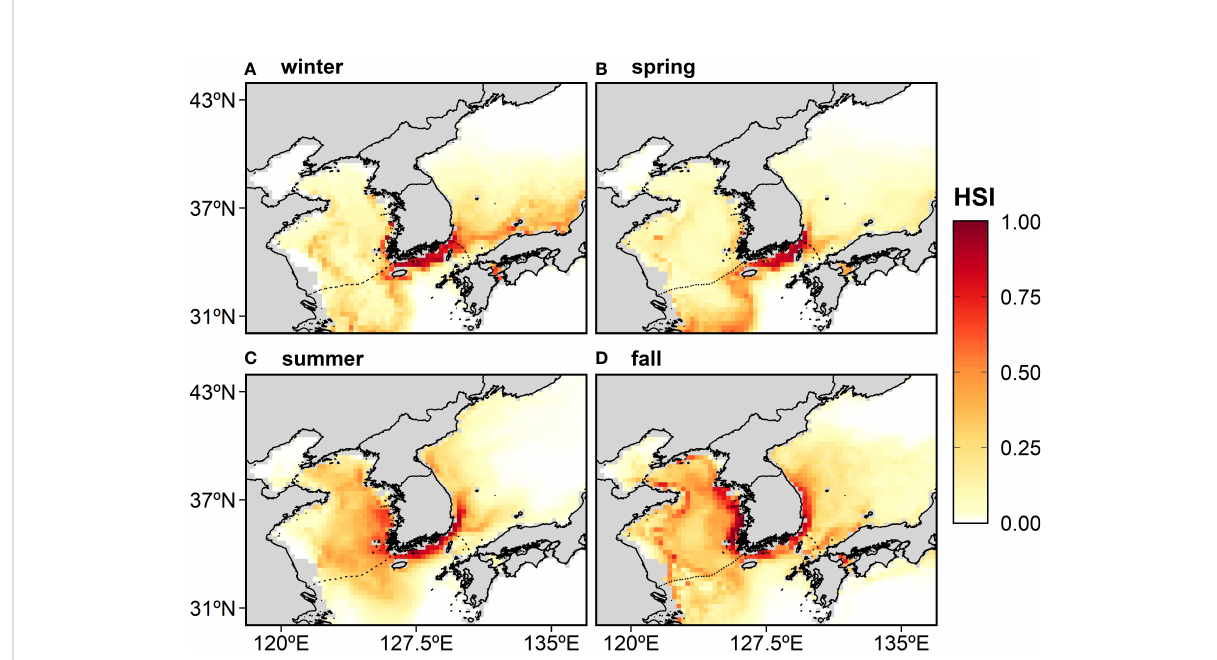
FIGURE 4 The distribution of the anchovy habitat suitability index (HSI) in Korean waters averaged over 16 years (2000 – 2015) and derived from the MaxEnt: (A) winter, (B) spring, (C) summer, and (D) fall. The reddish color indicates a highly suitable area or a high probability of